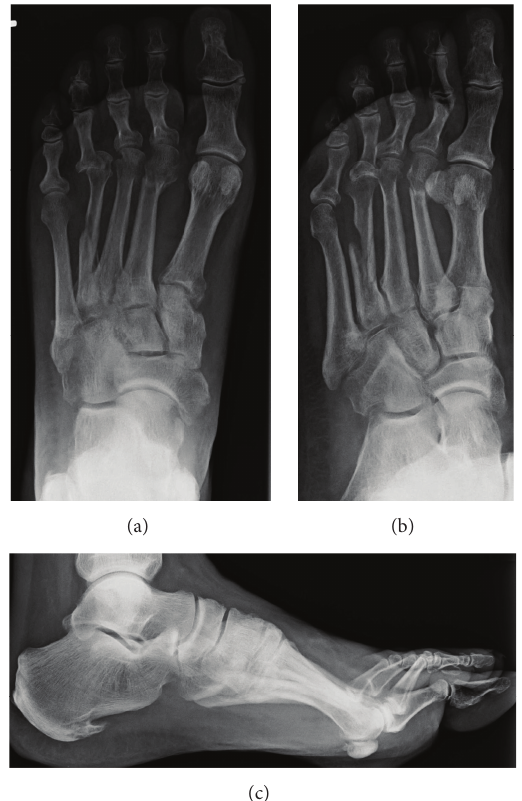
Figure 2: Preoperative dorsoplantar (a), oblique (b), and lateral (c) radiographs of the left foot showing malunion at fracture site, resulting in a lengthened fourth MT, and a dorsal dislocation at the fourth MTP